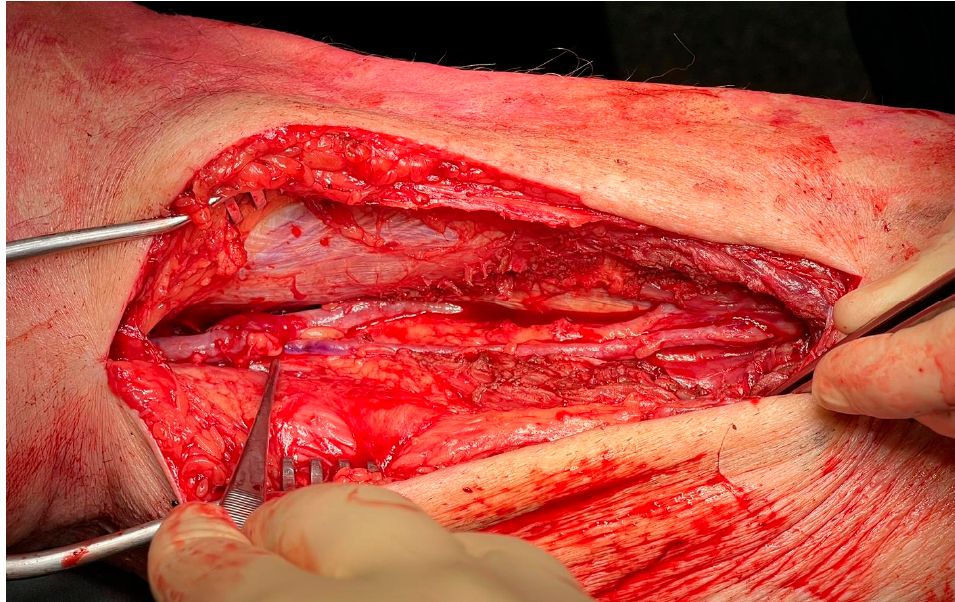
Figure 3. Infragenicular vein bypass in CLTI patient.